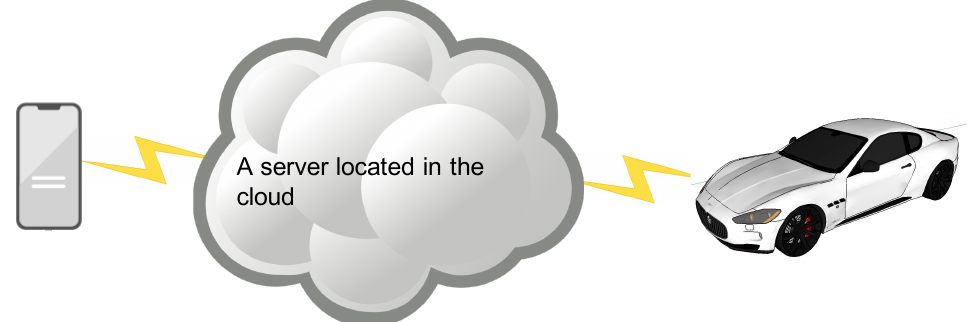
Figure 15. Smartphone-based implementation of the proposed solution. The instantaneous location of the smartphone is determined using the Global Navigation Satellite System (GNSS) service, and shared with the vehicle via a cloud